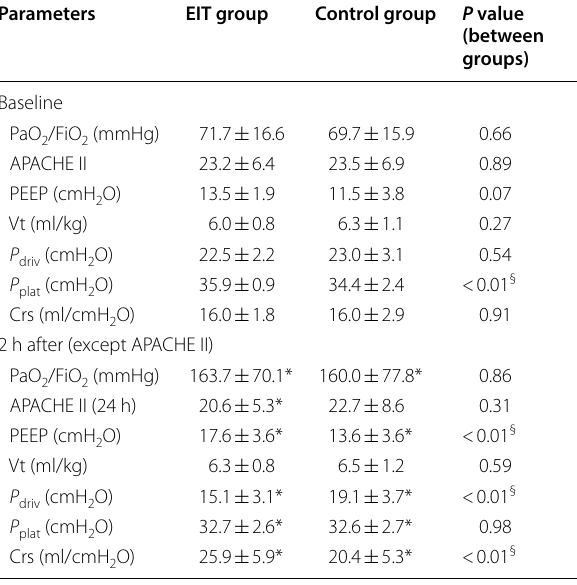
Table 2 Parameters comparison at baseline and 2 h after the PEEP